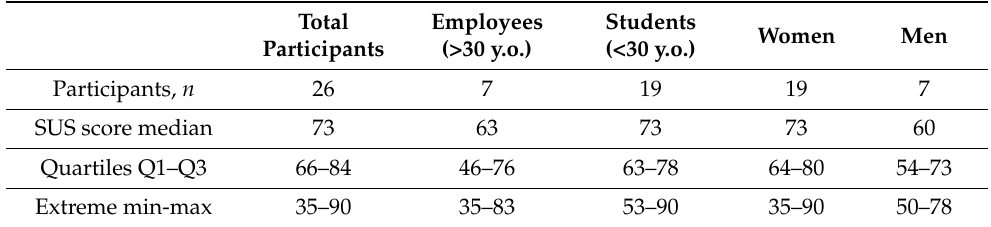
Table 5. System Usability Scale (SUS) scores for a 24HDR with myfood24 France for the total sample and stratified by age group and gender. Total Employees Participants (>30